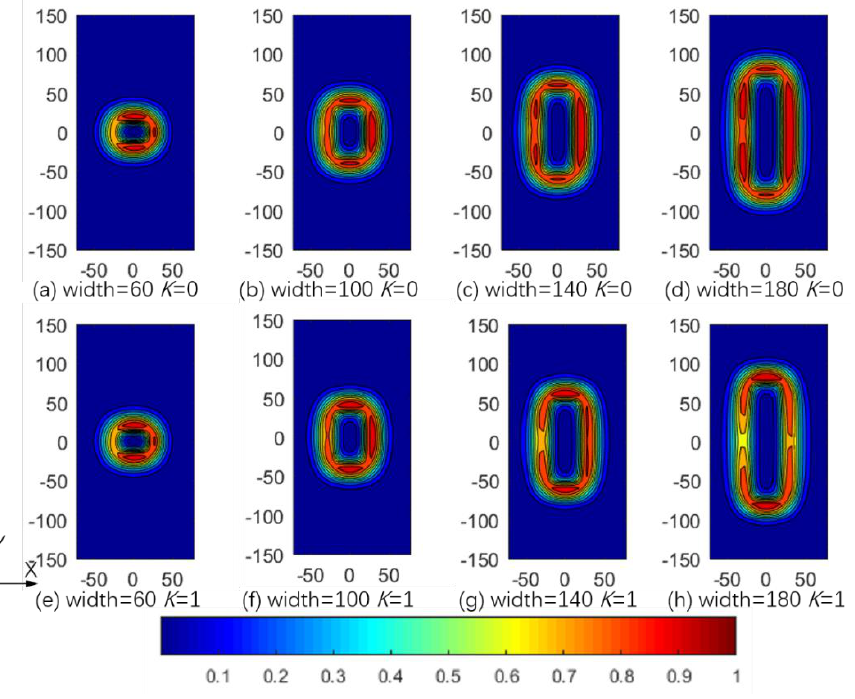
Figure 13. Heat source distribution comparison.